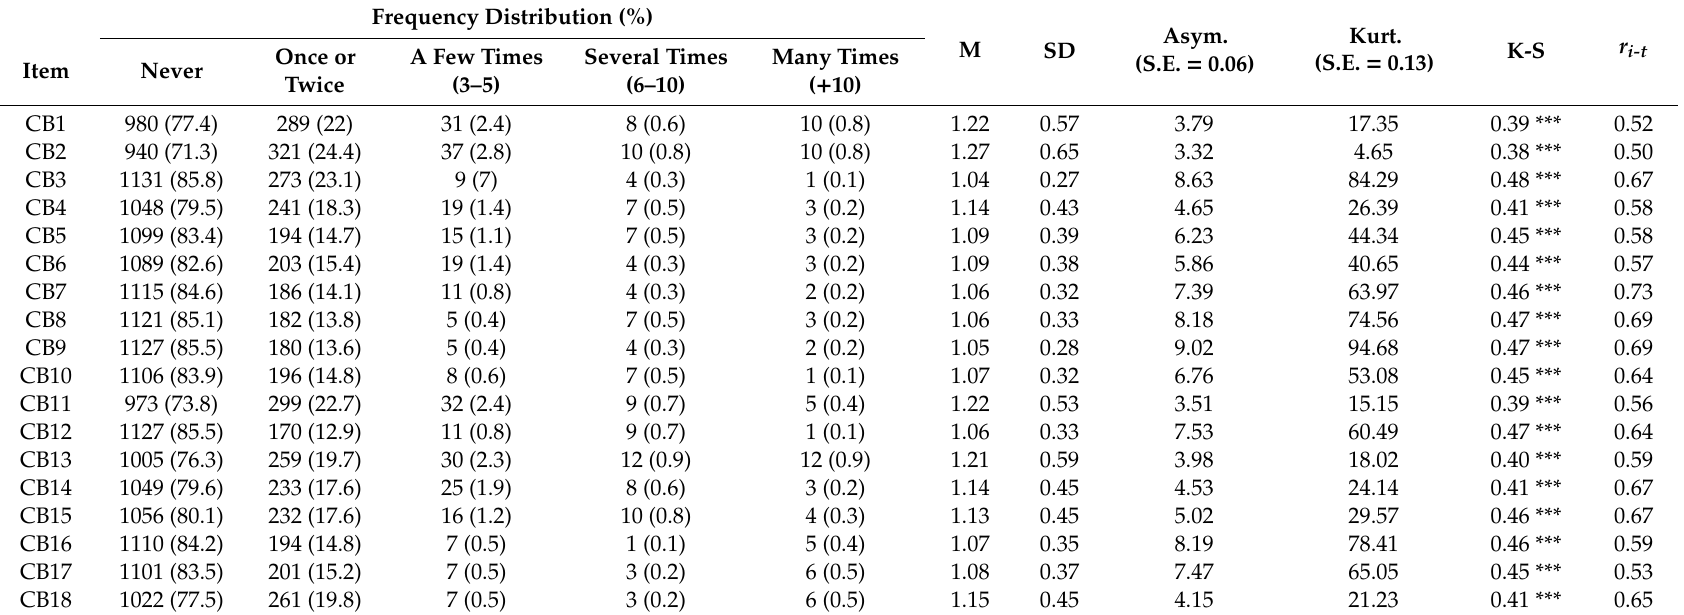
Table 1. Descriptive statistics for the cyber aggressor scale